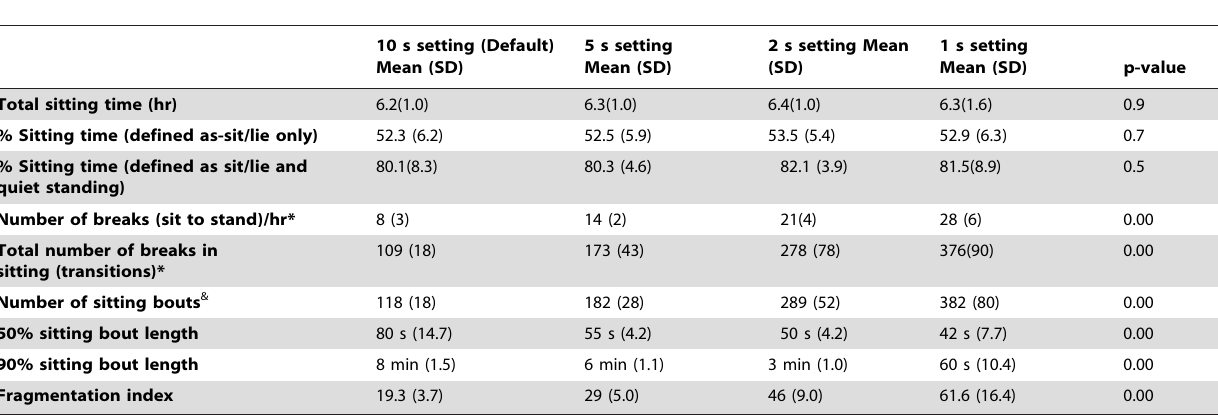
Table 1. Description of sitting behaviors during waking hours + , mean (SD) for study 1 (n= 20).